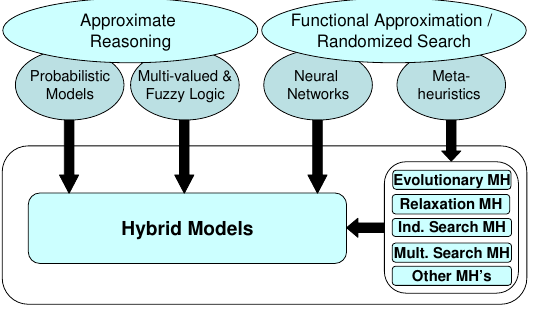
Fig. 7. Meta-Heuristics Extension (adapted from reference